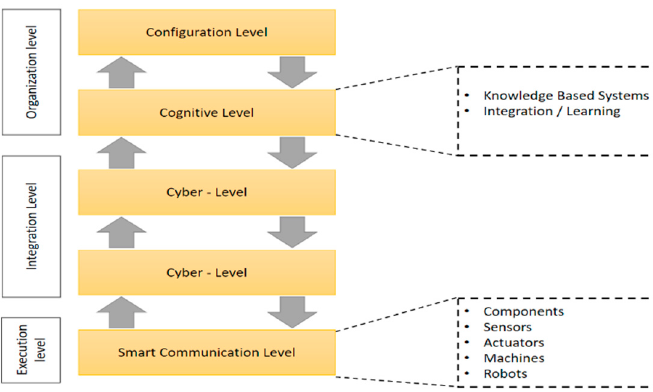
Figure 1. CPS-based enterprise model. Adapted from [16].